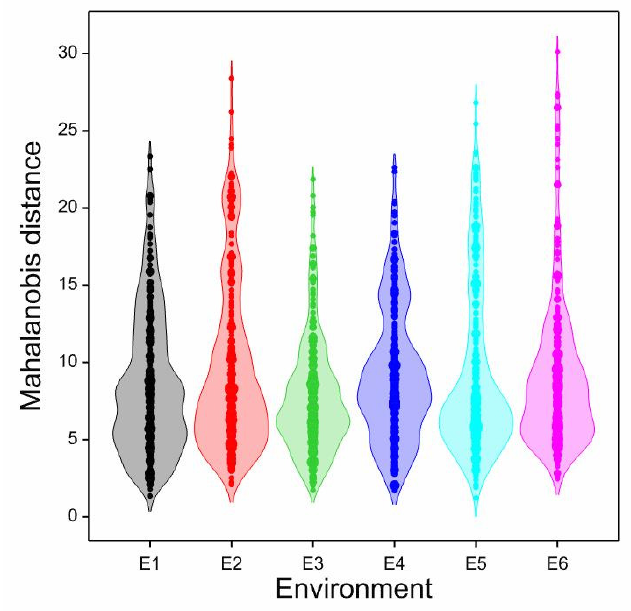
Figure 9. Range of Mahalanobis distances between all studied genotypes in six environments of study. E1—Borowo, 2015; E2—Borowo, 2016; E3—Borowo, 2017; E4— Ł agiewniki, 2015; E5— Ł agiewniki, 2016; E6— Ł agiewniki, 2017.